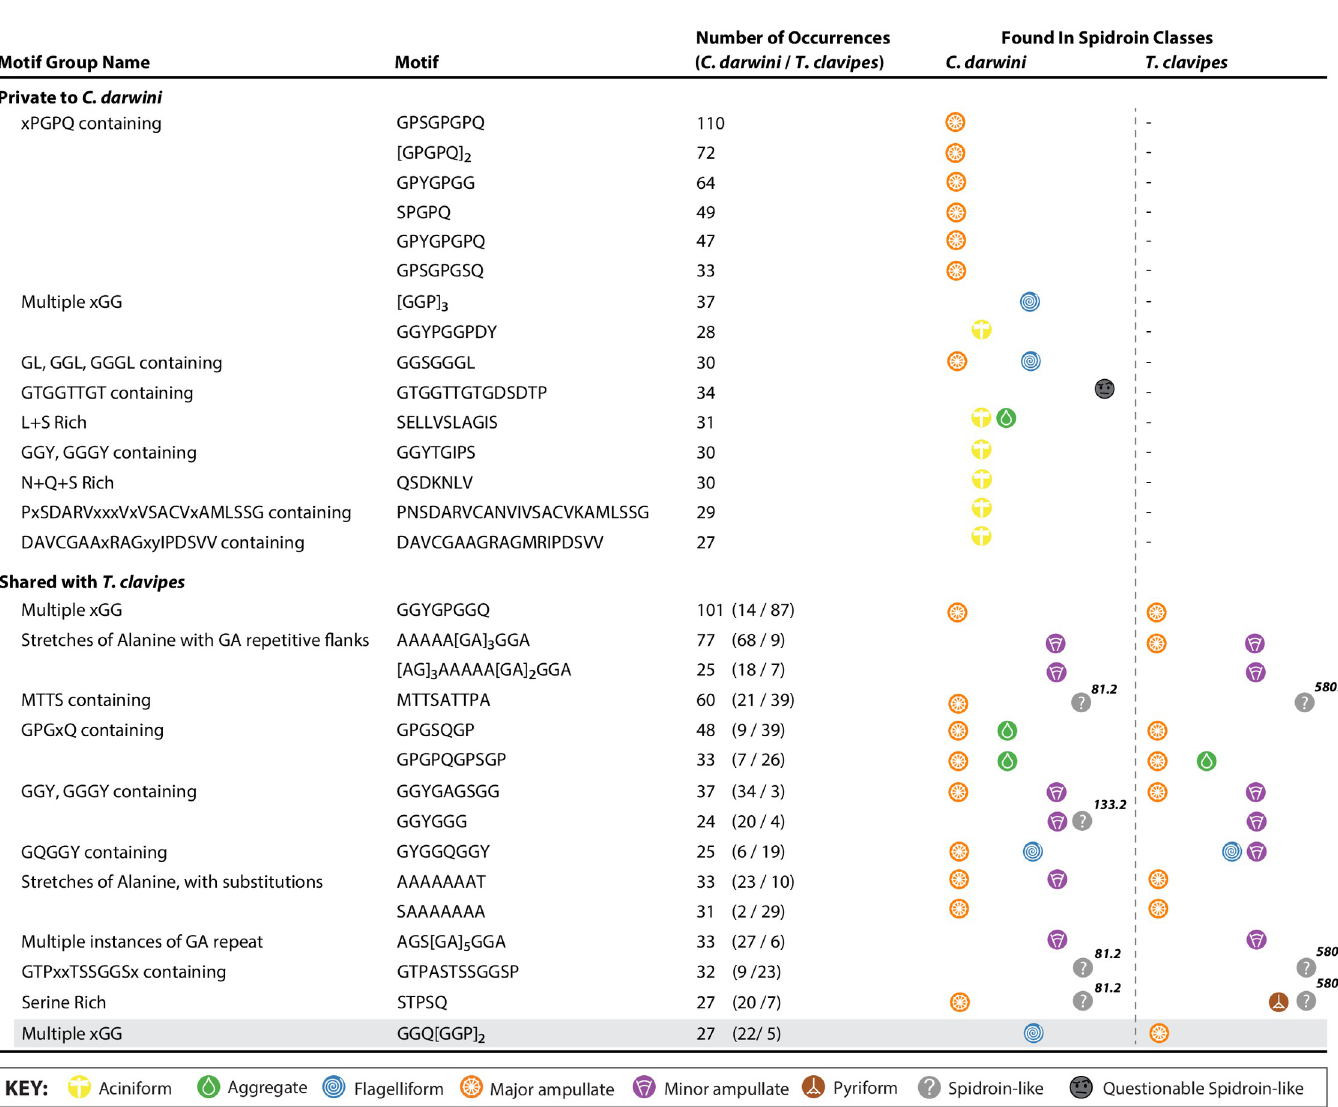
Fig 2. Most frequent coding repeat sequence motifs found only in Caerostris darwini or shared with Trichonephila clavipes . Top 15 most frequently observed motifs that were exclusive to C . darwini (upper frame) or shared with T . clavipes (lower frame). For motifs found in spidroin-like genes or atypical spidroin genes, a brief label for the name of the gene is provided (e.g., 81.2, 133.2, and 5803). The single example where motif usage was shared but utilized in different spidroin classes is